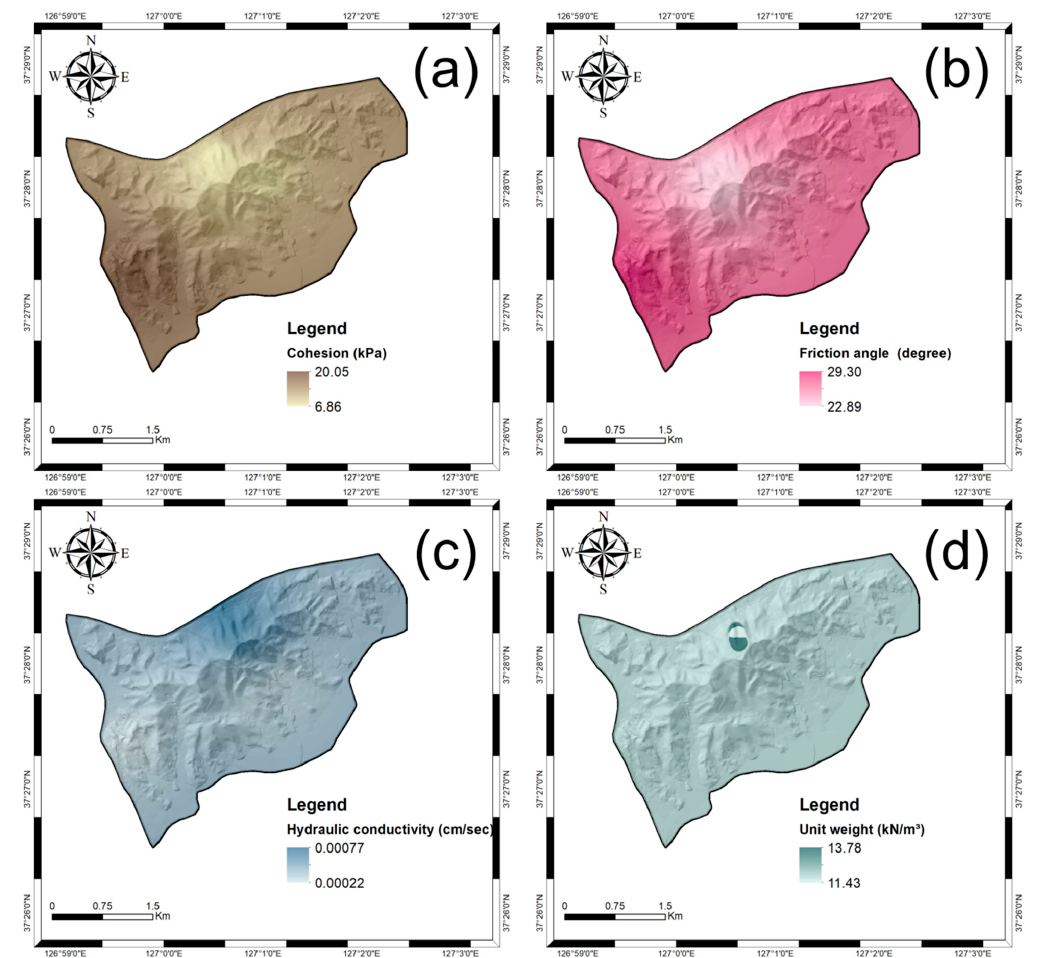
Figure 6. Map showing input parameters constructed using kriging interpolation based on the geotechnical properties of the sampling location ( a ) cohesion; ( b ) friction angle; ( c ) hydraulic conductivity; ( d ) unit weight.